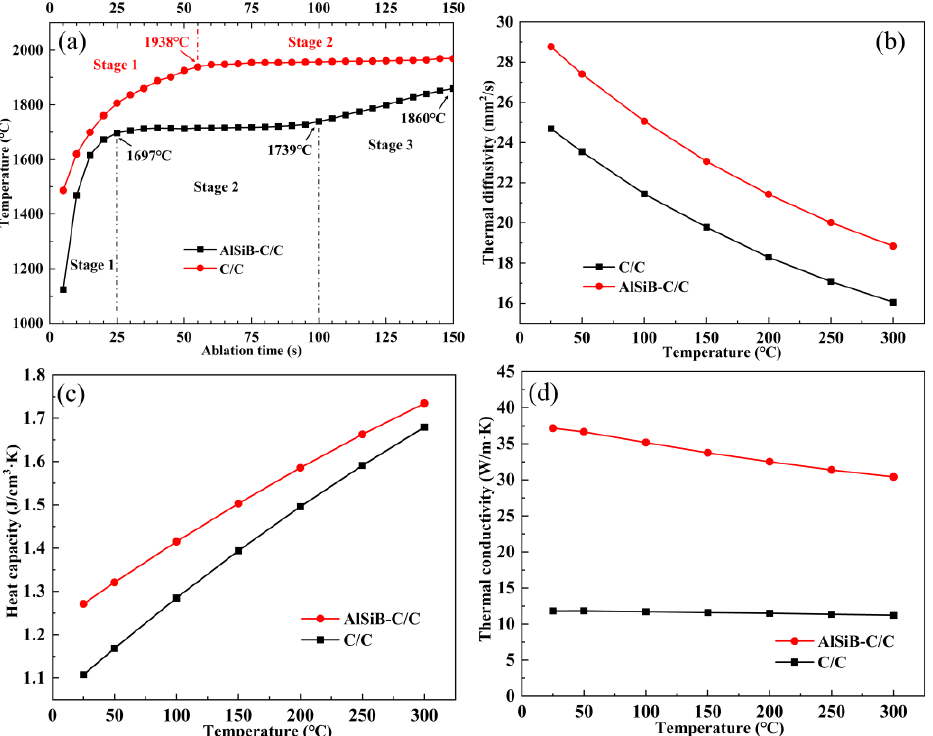
Figure 6. ( a ) Surface temperature changes during ablation, ( b ) thermal diffusivity, ( c ) heat capacity per unit volume and ( d ) thermal conductivity for the C/C and the AlSiB-C/C composites.